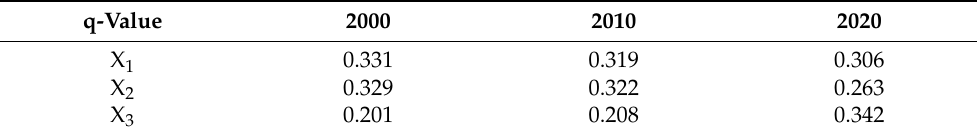
Table 6. Detection of the impacts of urbanization subsystem factors on ecosystem health,